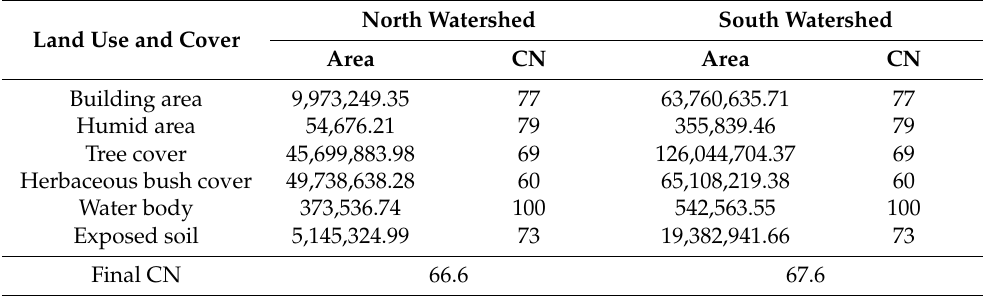
Table 6. Land use and land cover for the composition of curve-number coefficient. Land Use and